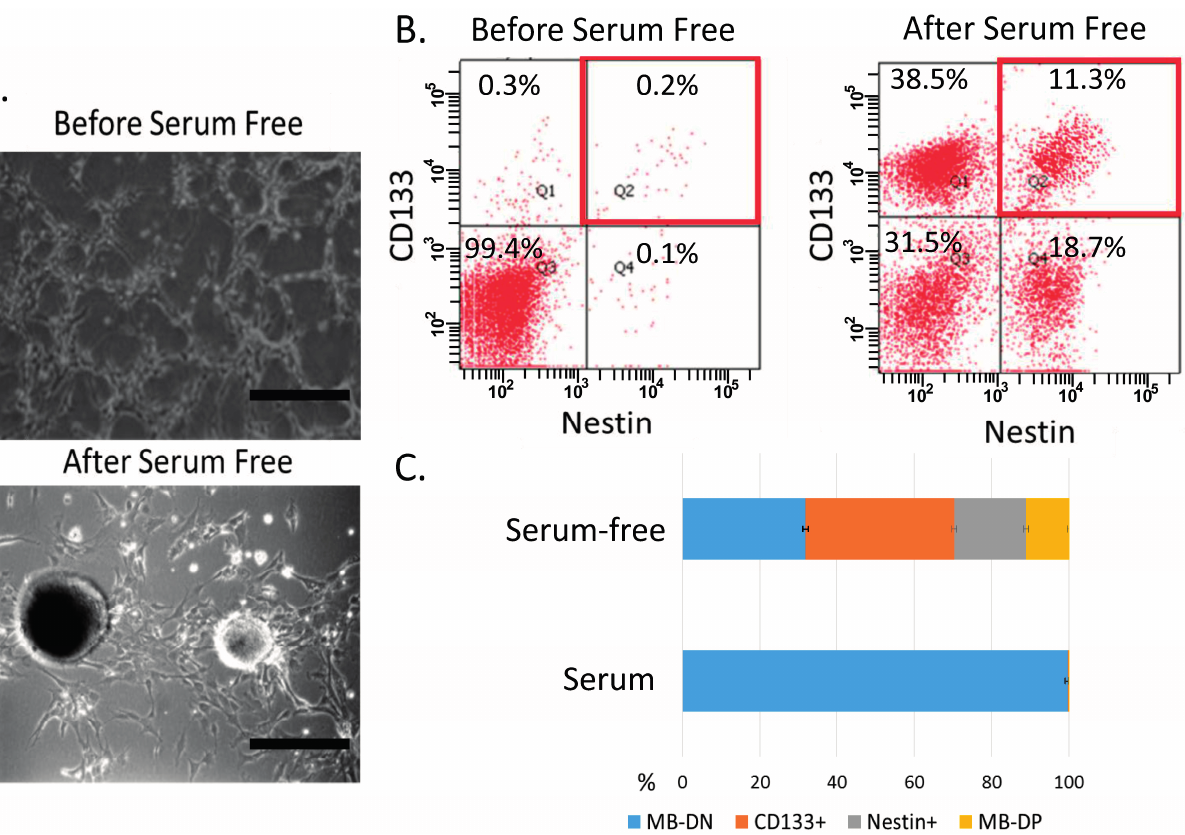
Figure 1. Enrichment of medulloblastoma-derived cancer cells double-positive cells for both CD133/Nestin (MB-DPs). ( A ) Daoy cells were cultured in the DF-12 serum-free medium with bFGF and EGF (20 ng/mL) for 4 weeks. Spheroid-like bodies were identified using phase contrast microscopy. Bar 100 μ m; ( B ) Using fluorescence activated cell sorting, MB-DP cells were sorted from medulloblastoma cell line, Daoy. The populations of MB-DP cell populations were confirmed by flow cytometry; and ( C ) The percentages of the various sub-populations in Figure 1B. The experiments were repeated at least three